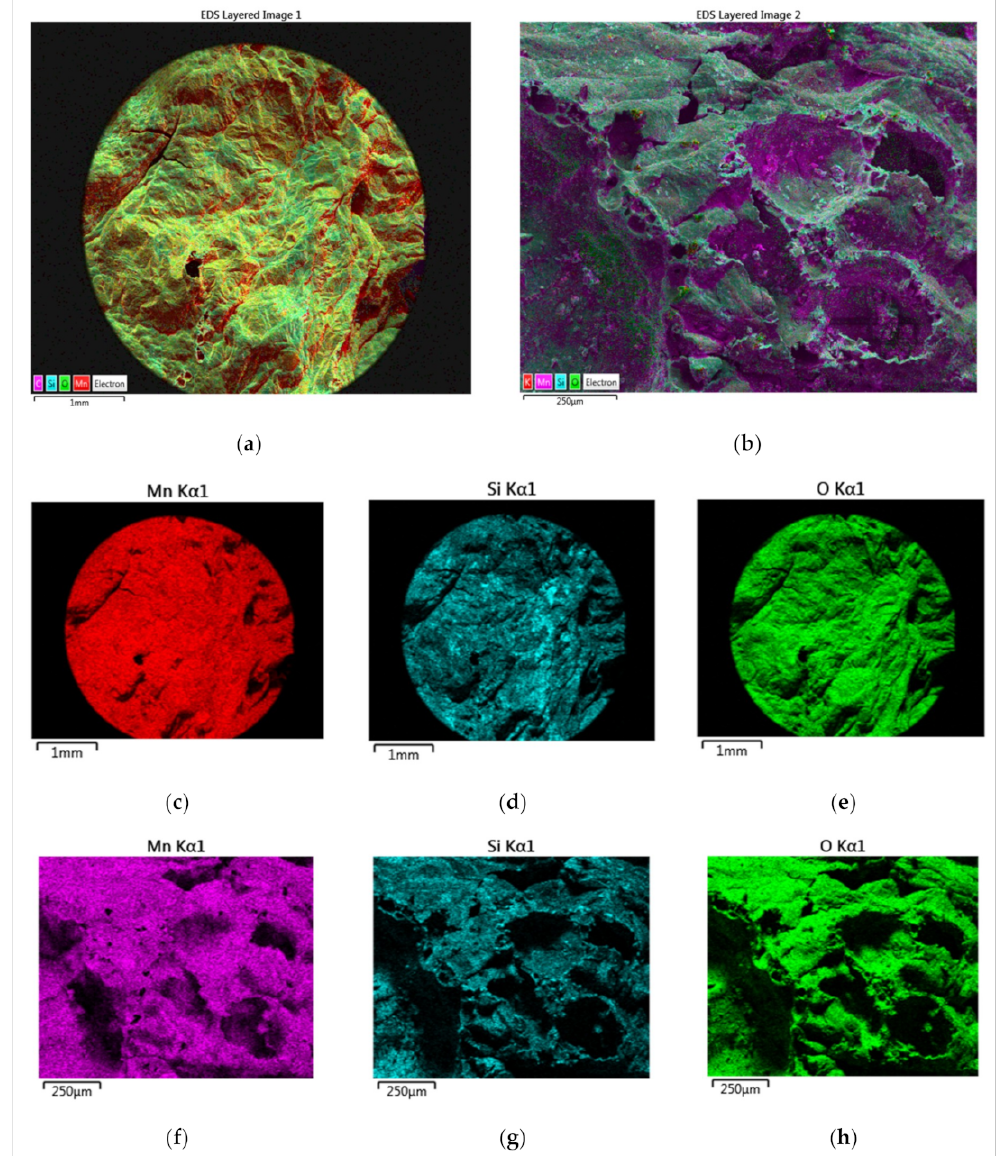
Figure 26. EDS images and elemental mapping of Mn / Si = 2 catalyst at two di ff erent magnifications. ( a ) EDS image at low magnification showing the whole particle (scale bar = 1 mm); ( b ) EDS image at high magnification showing the regions of high and low Mn concentrations (scale bar = 250 µ m); ( c – e ) Mapping of Mn, Si, O at low magnification; ( f – h ) Mapping of Mn, Si, O at high magnification used in spot analysis to determine the regions of low- and high-Mn